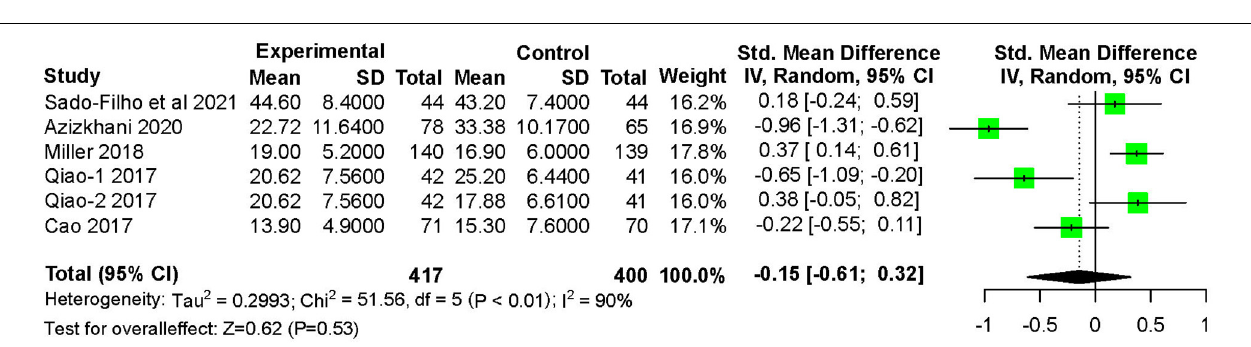
FIGURE 9 | Meta-analysis of nebulized dexmedetomidine for onset of sedation. CI, confidence interval; df, degress of freedom; M-H,